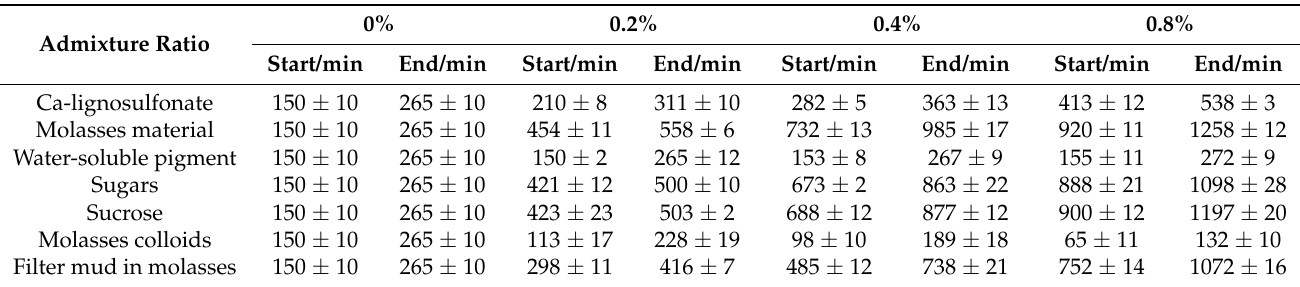
Table 3. Effects of different additives on cement condensation